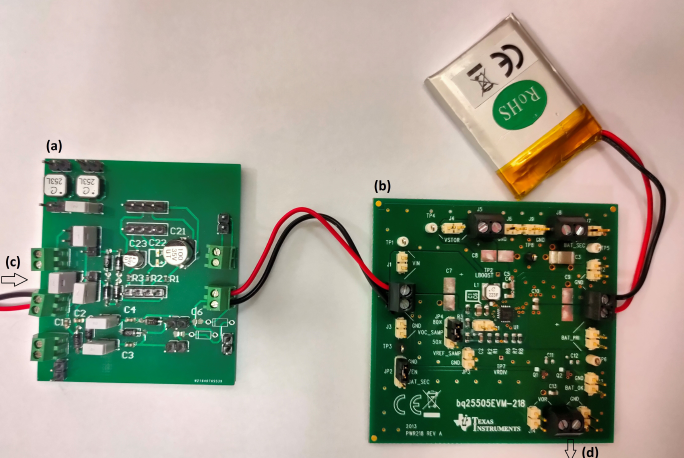
Figure 8. ( a ) Rectifier; ( b ) bq25505 battery controller evaluation board; ( c ) harvester’s output; ( d ) battery controller’s